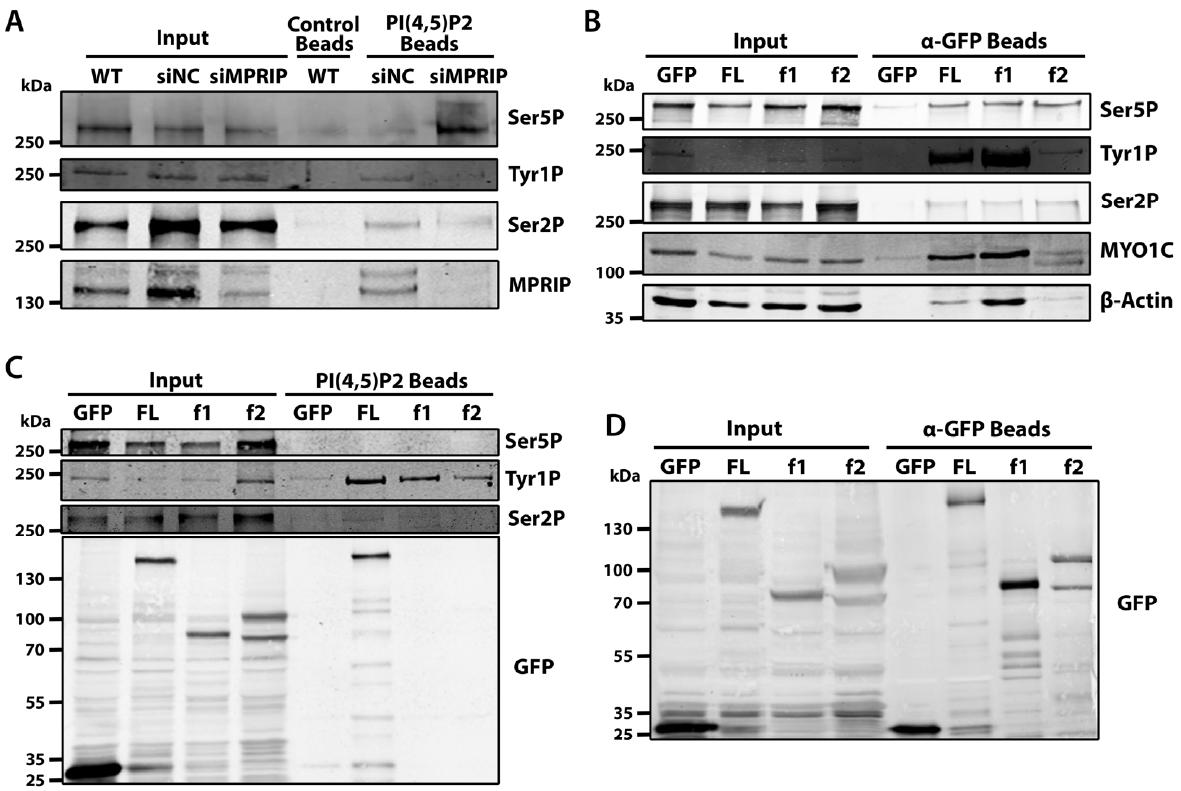
Figure 4. ( A ) MPRIP regulates the association between RNAPII and PIP2. PIP2 coated agarose beads are used as bait to pull down interacting proteins from U2OS cell lysates. The membrane is